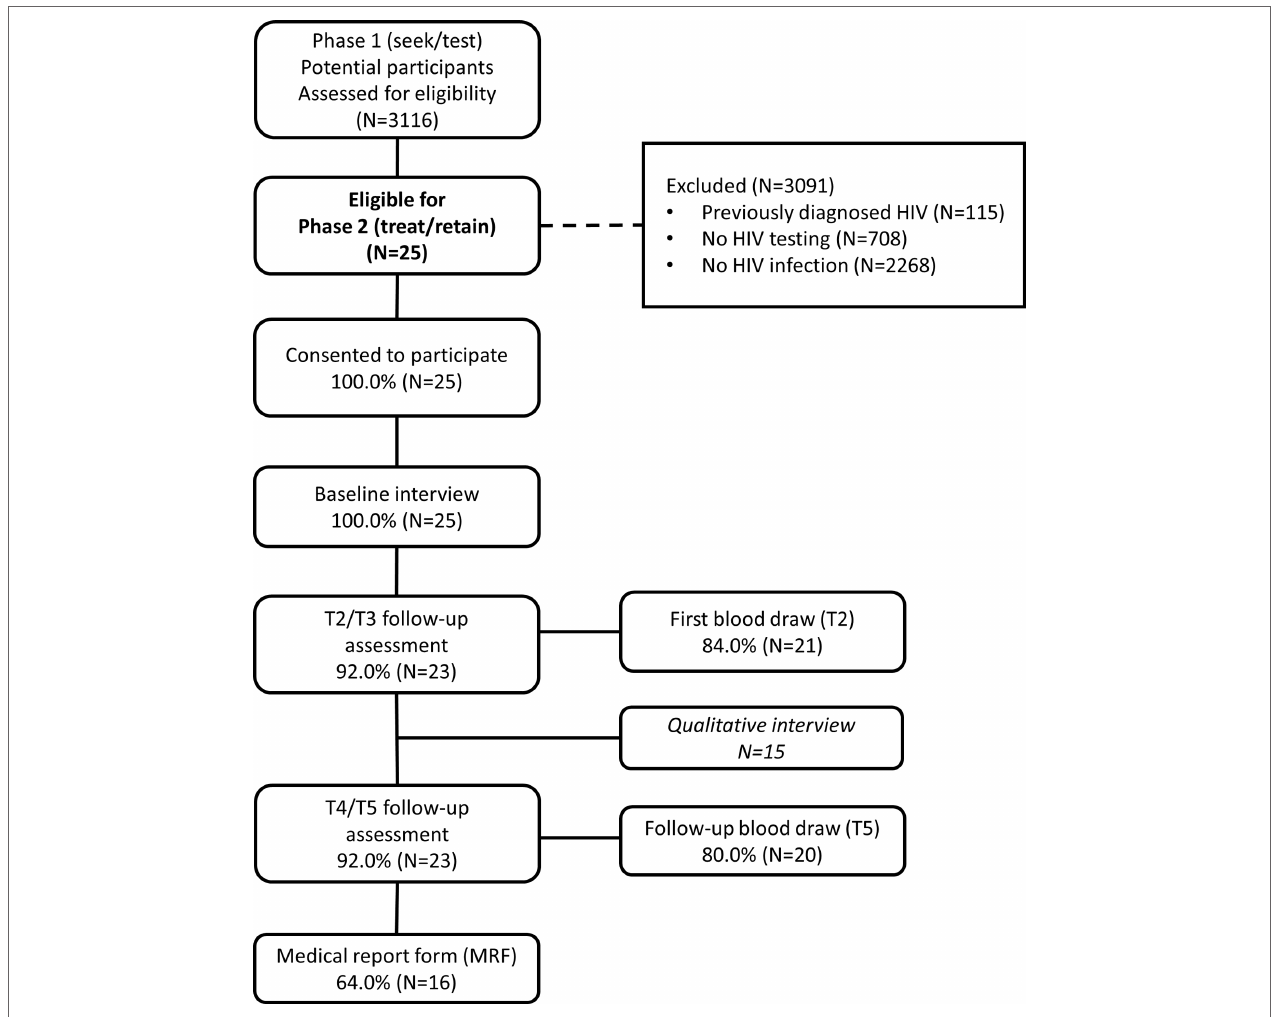
FigUre 1 | retention in study activities